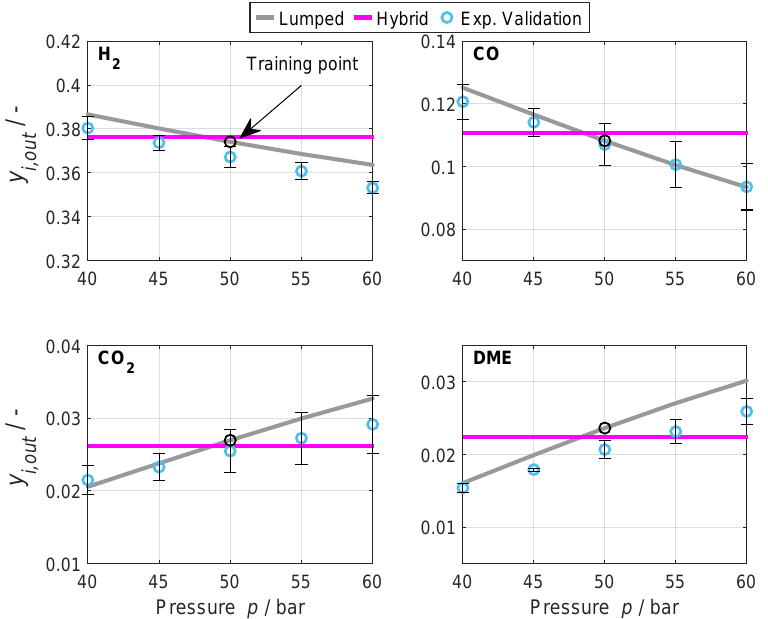
Figure 9. Experimental validation of dimensional extrapolation of the pressure. Feed composition: 42.3% H , 16.1% CO, 0.82% CO 2 µ = 1. ANN-HM with 26